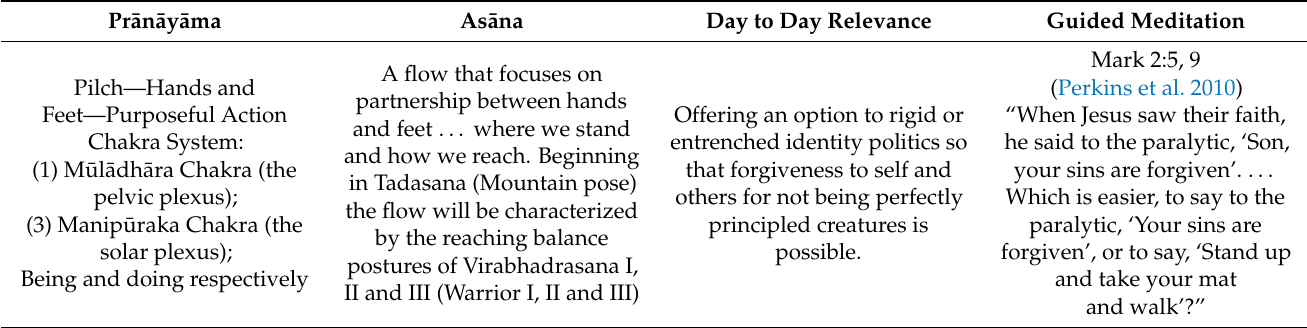
Table 4. Forgiveness Flow—Practice